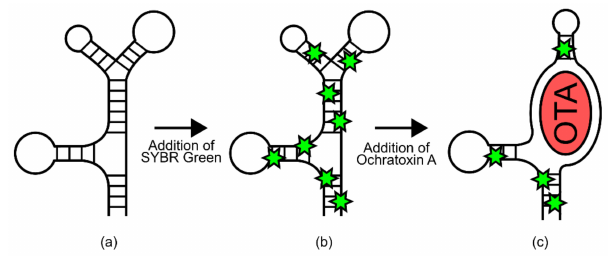
Figure 6. Ochratoxin A biosensor. The biosensor is comprised of a DNA aptamer for Ochratoxin A ( a ) aptamer with no added SYBR Green or Ochratoxin A; ( b ) coordinated with SYBR Green (green star); ( c ) and coordinated with OTA (red oval) and SYBR Green. Coordination of OTA to the aptamer results in decreased binding sites for SYBR Green, and therefore decreased fluorescence. Figure adapted from McKeague, et al.